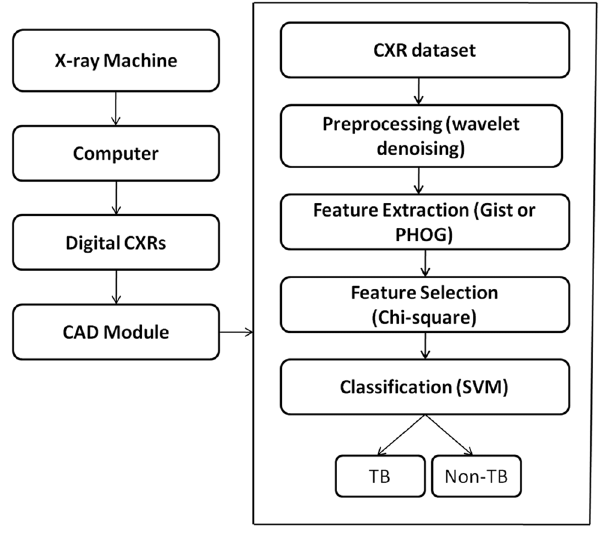
Figure 2. Schematic representation of CAD implementation for TB. CAD module is applied to the digital CXRs obtained from the computer attached to the the X-ray machine. The CAD module preprocesses (denoises) the image using SURE wavelet denoising, extract features (Gist and PHOG), selects relevant features using chi- square based feature selection method and finally classifies the CXR into TB and non-TB.